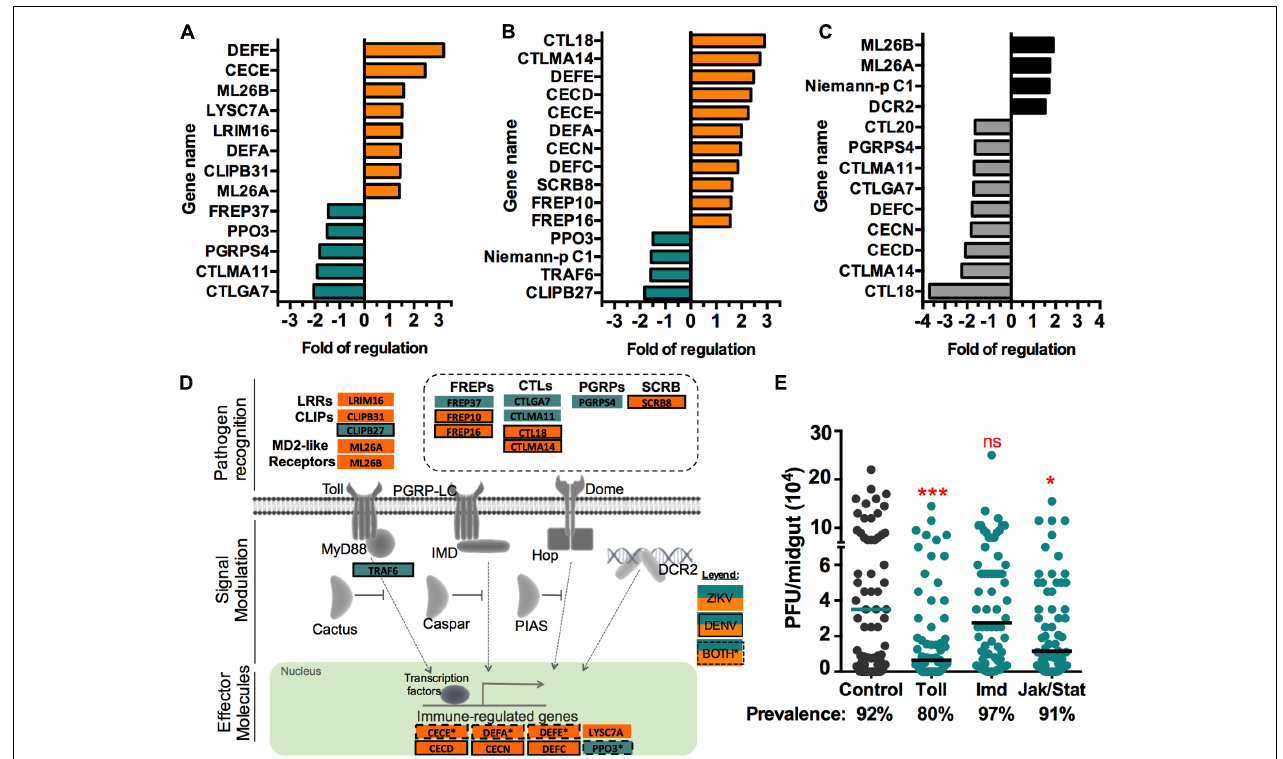
FIGURE 3 | Infection-responsive immune genes. The fold change of putative immune gene transcript abundance upon midgut infection with (A) ZIKV or (B) DENV, as compared to non-infected blood-fed controls. Orange indicates upregulation, blue downregulation. (C) The fold difference in transcript abundance of immune genes between ZIKV- vs. DENV-infected midguts; black and gray indicates genes showing a higher transcript abundance in ZIKV and DENV infected midguts, respectively. (D) Schematic representation of the four main immune pathways (Toll, Imd, Jak/Stat, and RNAi). Boxes without lines represent ZIKV infection-responsive genes, boxes with solid lines represent DENV infection-responsive genes, and boxes with dashed lines represent genes regulated upon infection with either virus. (E) Immune pathway activation demonstrated through dsRNA-mediated silencing of the negative regulators of the Toll pathway (dsCactus, N = 65), Imd pathway (dsCaspar, N = 66), and Jak/Stat pathway (dsPIAS, N = 65). GFP dsRNA was used as a control ( N = 62). ZIKV infection was measured as PFU in individual midguts at 7 days post-infection. The bars represent the median. ∗ P < 0.05, ∗∗ P < 0.01, ∗∗∗ P < 0.001; Mann-Whitney